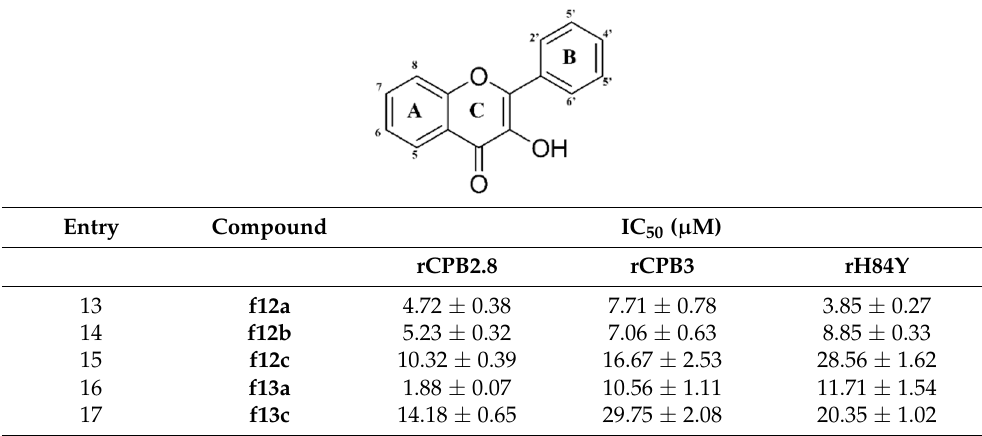
Table 3. Flavonol-like inhibition potential (IC 50 ) in modulating the enzyme activity of Leishmania mexicana cysteine proteases rCPB2.8, rCPB3, and rH84Y.